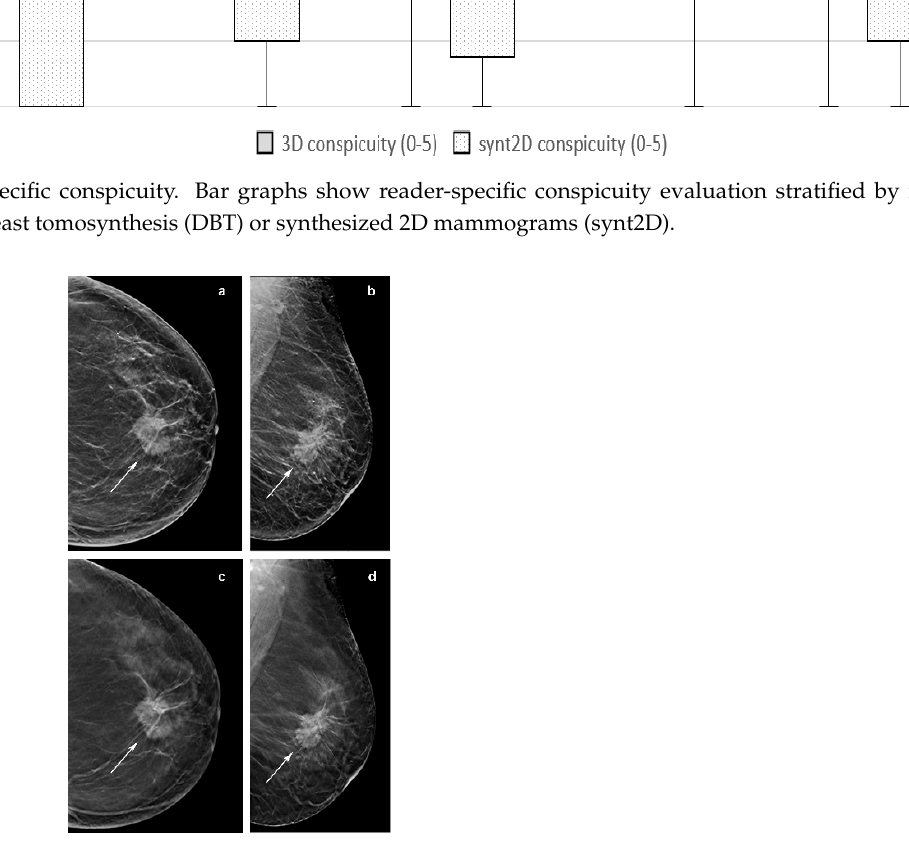
Figure 4. Images of a 65-year-woman with a 38 mm, spiculated and palpable mass (arrow in a − d ) in the upper central quadrant of the left breast detected at screening with digital breast tomosynthesis (DBT) plus synthetic mammography (synt2D). Mass was invasive lobular carcinoma. ( c ) Image from single-slice DBT in craniocaudal view. ( d ) Single-slice DBT image in mediolateral oblique view. ( a ) Image from synt2D in craniocaudal view. ( b ) Image in mediolateral oblique synt2D view. The mass is easily identifiable in synt2D and DBT, but DBT ( c , d ) increases the contrast, emphasizing the presence of spicules, and resulting in a better estimate of size.